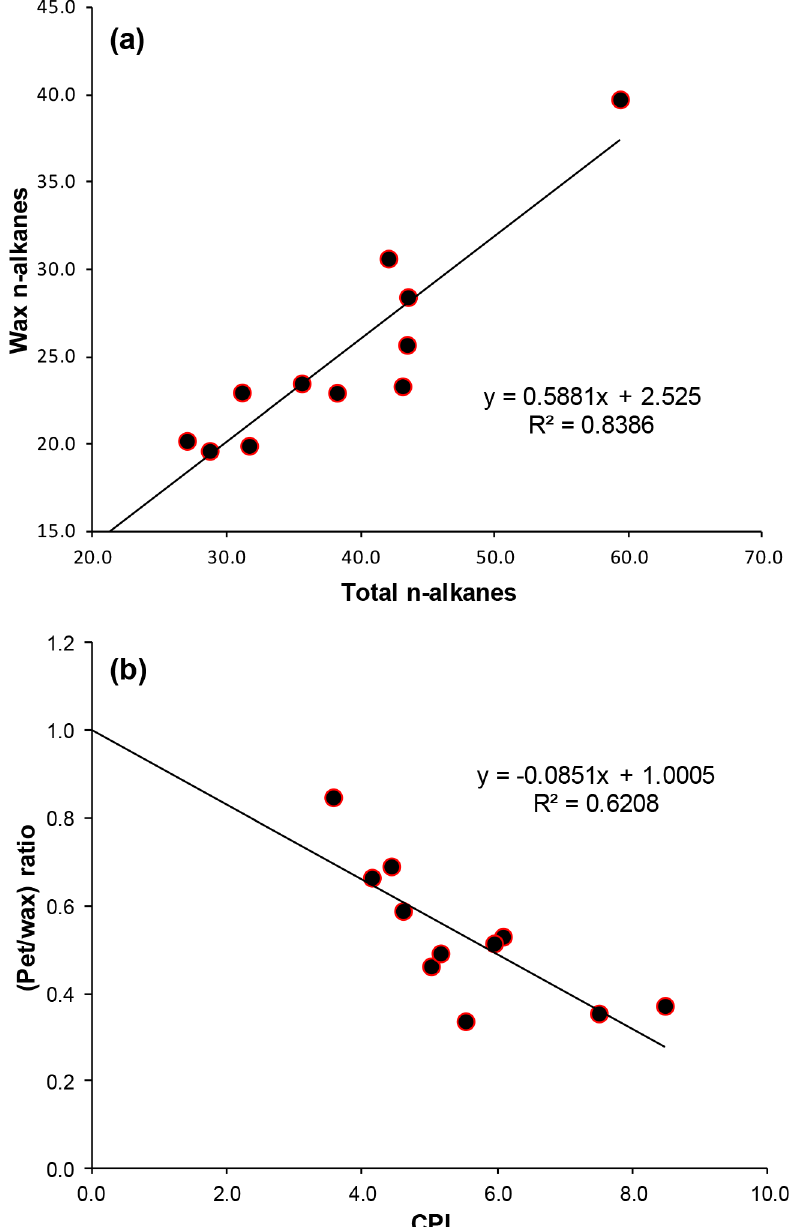
Fig 4. Plots showing the relationships between (a) wax n-alkanes versus total n-alkanes and (b) petroleum-to-biogenic n-alkane ratios versus CPI of